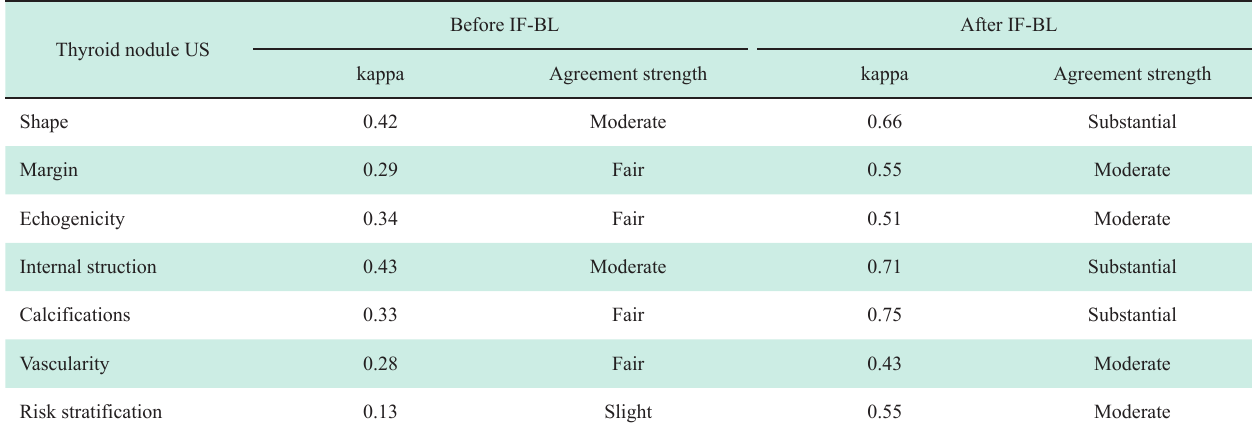
Table 2 Inter-observer agreement for US thyroid nodule evaluation after